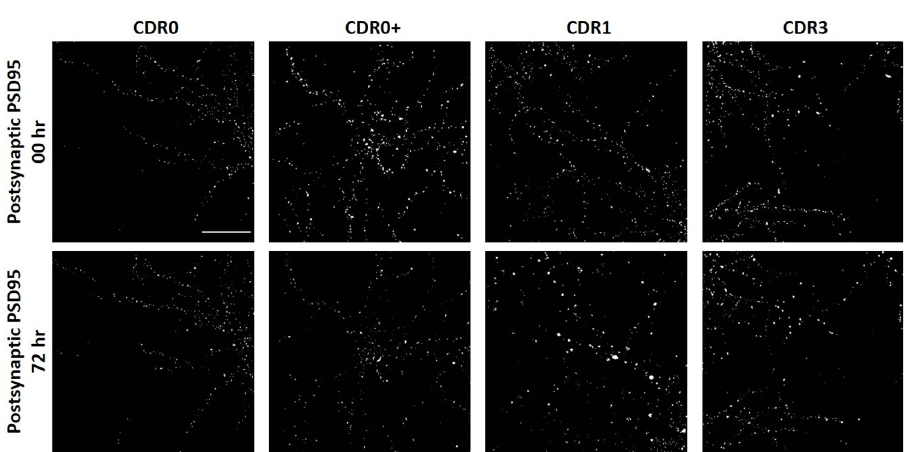
Fig 5. Representative images of PSD95 changes at baseline (00 hr) and after 72 hours incubation with homogenate Fraction 18 from CDR0, CDR0+, CDR1, and CDR3 groups. Mild loss of PSD95 was observed in CDR0 group, while severe loss of PSD95 was observed in CDR0+ and CDR1 groups. Scale bar = 50 μ m.